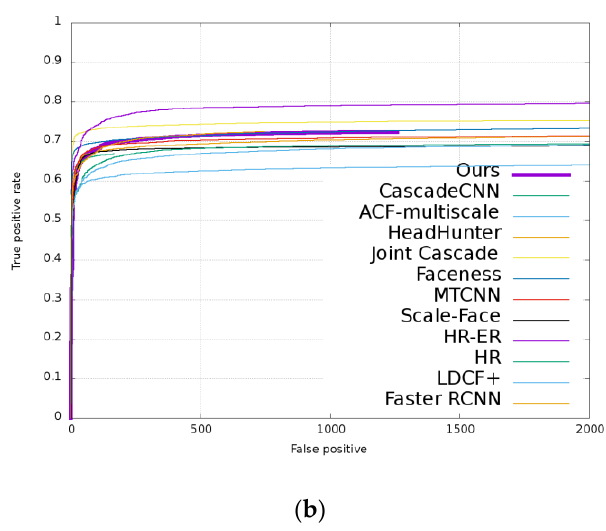
Figure 6. Receiver operating characteristic (ROC) curves on FDDB dataset. ( a ) Discontinuous ROC curves; ( b ) Continuous ROC curves.